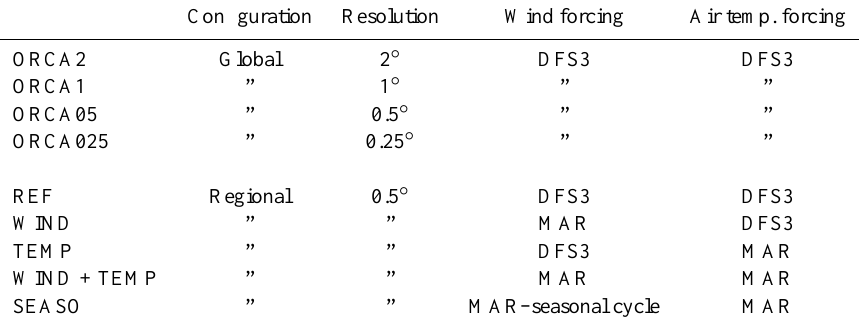
Table 1. Simulations description (resolution, forcing and